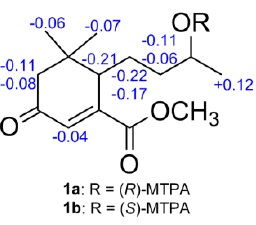
Figure 3. ∆δ values (in ppm) = δ S -MTPA-ester − δ R- MTPA-ester for 1a and 1b .